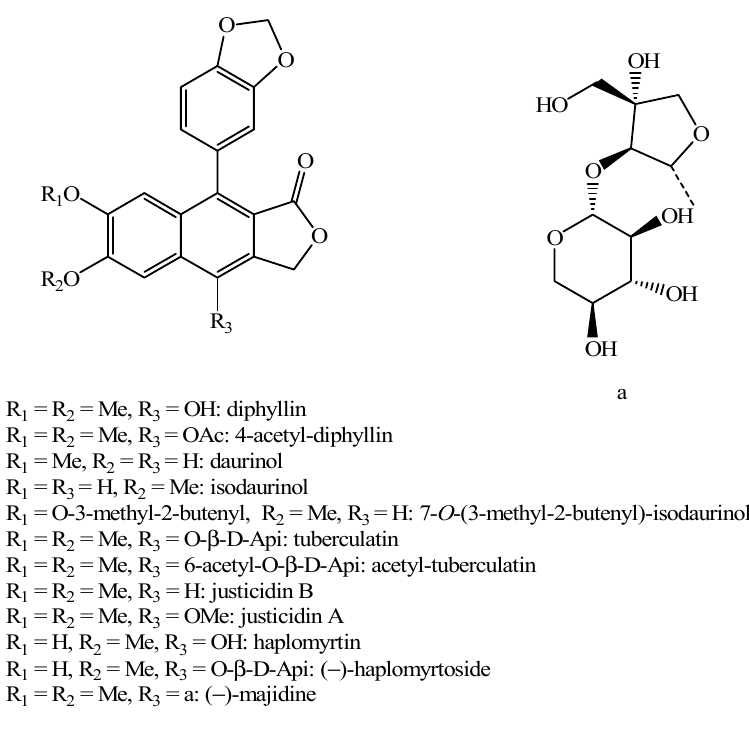
Figure 12. Structure of the lignans identified in Haplophyllum species—part 3.